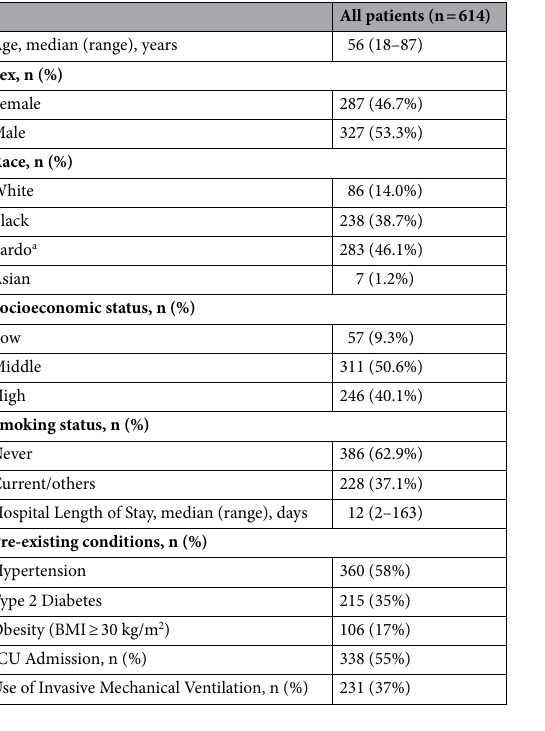
Table 1. Sociodemographic and clinical characteristics of patients. BMI Body mass index, ICU Intensive care unit. a Pardo is the exact term used in Brazilian Portuguese, meaning “mixed ethnicity,” according to the Brazilian Institute of Geography and